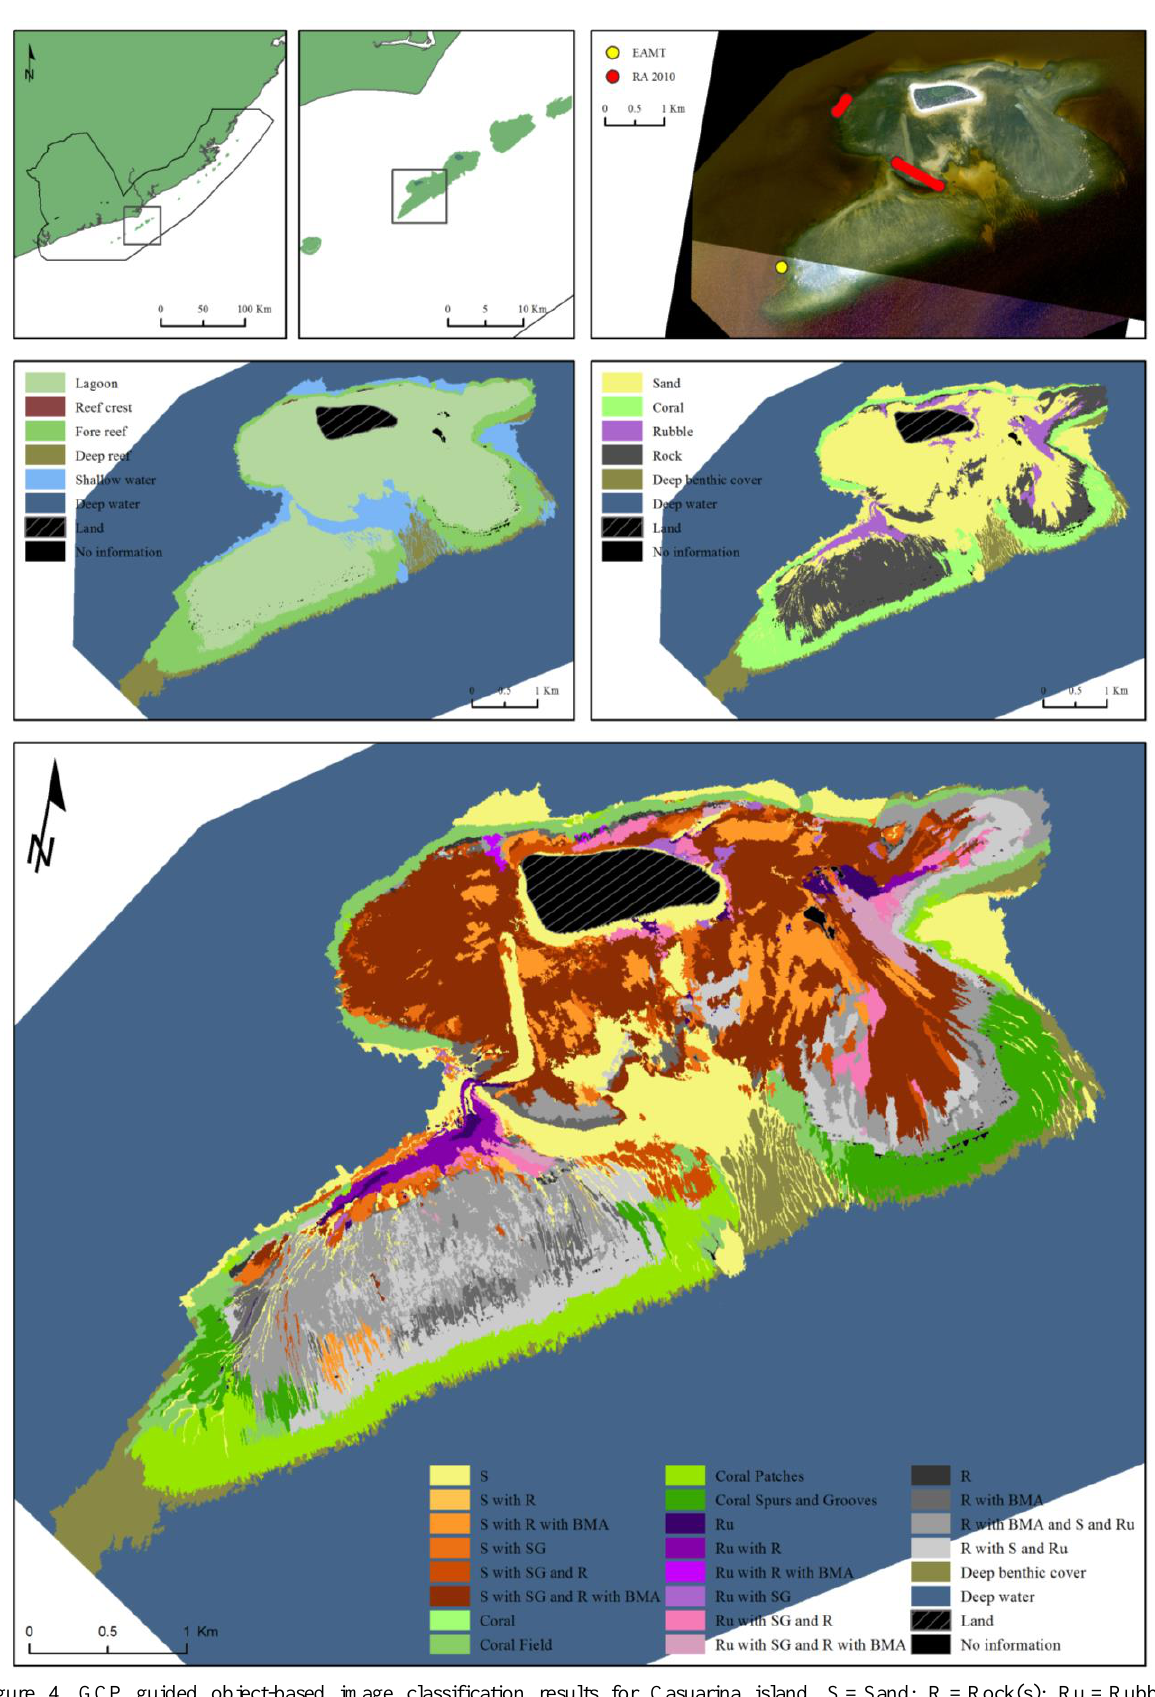
Figure 4. GCP guided object-based image classification results for Casuarina island. S = Sand; R = Rock(s); Ru = Rubble; BMA = Brown Macroalgae; SG = Seagrass. Projected coordinate system: CGS WGS 1984. Imagery data sources: Quickbird02, Worldview02, Ikonos. Point data sources: Delacy, Bennett et al. 2014, Pereira and Videira 2007, Pereira and Rodrigues